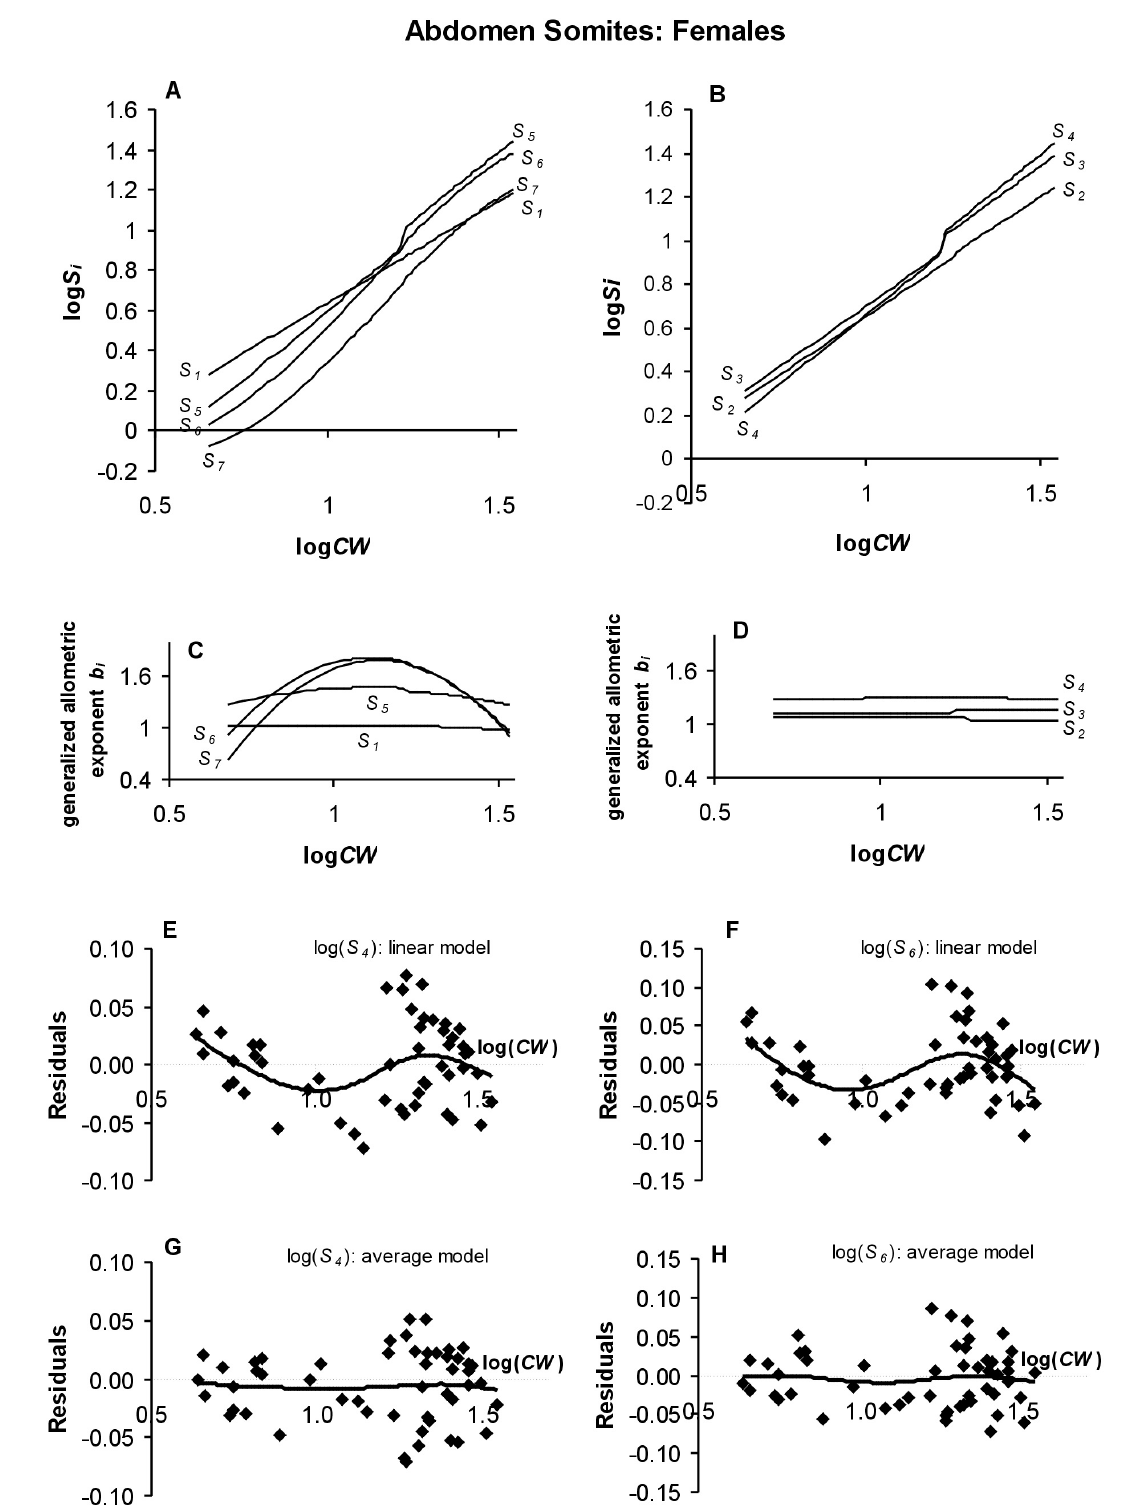
F IG . 2. – (A, B) The relative growth patterns of the width of abdominal somites ( S ) of female P. marmoratus according to the corresponding i were used for the weighted averages; somites S , S and S were separated for clarity. (C, D) The ‘average’ models; the Akaike weights w i 2 3 4 generalized allometric exponent b for the relative growth of each S of female P. marmoratus , calculated as the slope of the corresponding i ‘average’ models between log S and log CW . (E-H) Residual plots against log CW for the linear (E, F) and the average (G, H) models for i (C, E) and log S (D, F) in females, with a smoothing spline fitted to the log S 4 6